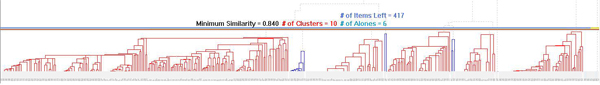
Functional clustering (biological process) of Clus2300 of mouse genome. Table 5 provides the details on functional cohesiveness.